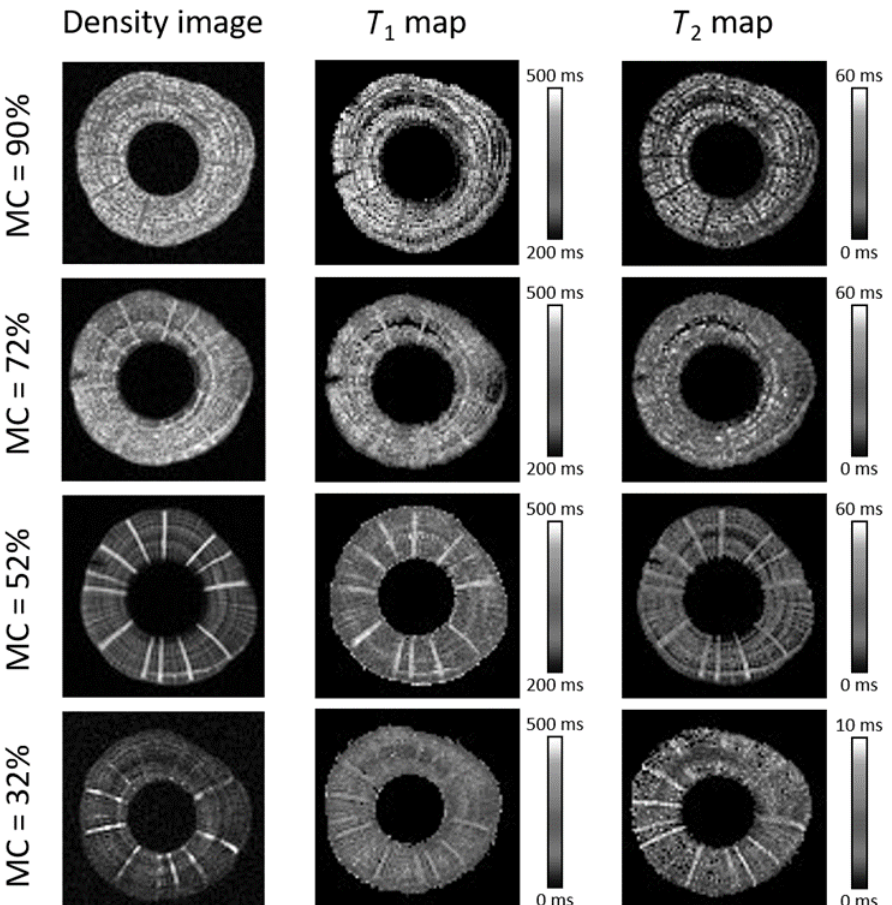
Figure 3. Density images, T 1 and T 2 maps of beech branchwood at different MCs. Note that the scales for the T 1 and T 2 maps are different for MC = 32% than for the higher MCs. In some MR maps, a dark region with shorter T 1 and T 2 values or even with non- defined relaxation times values is observed due to too low SNR. It is interesting to note where in the sample. This region is not observed in images at all the MCs because the removed from the magnet after measurement at each MC, and the slices of the images at different MCs might be slightly